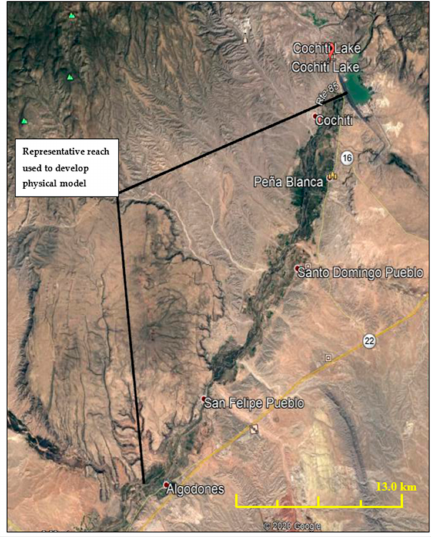
Figure 2. Aerial view from Cochiti Dam to Angostura Diversion Dam near Algodones, New Mexico (Google Earth 2020).